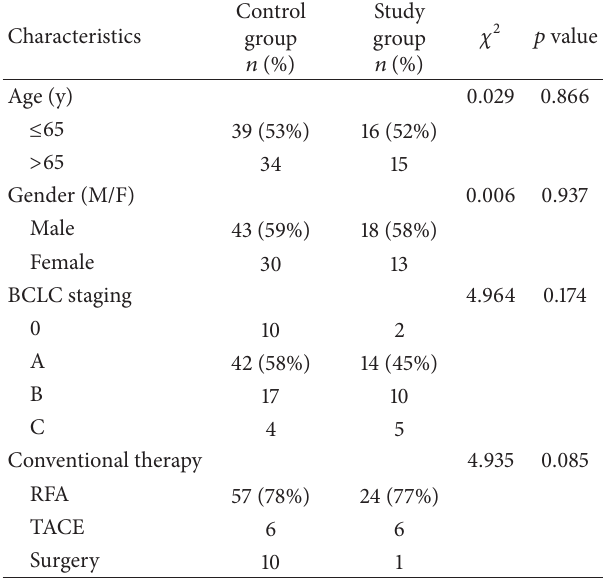
Table 1: The baseline characteristics of